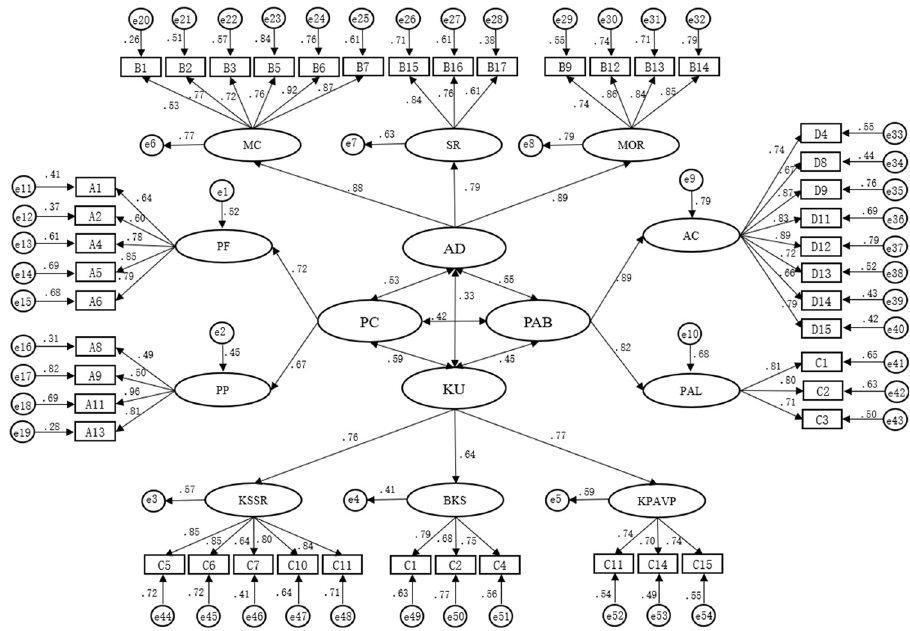
Fig 3. The first-order of factor structure and standardized factor loading on self- assessment physical literacy items.